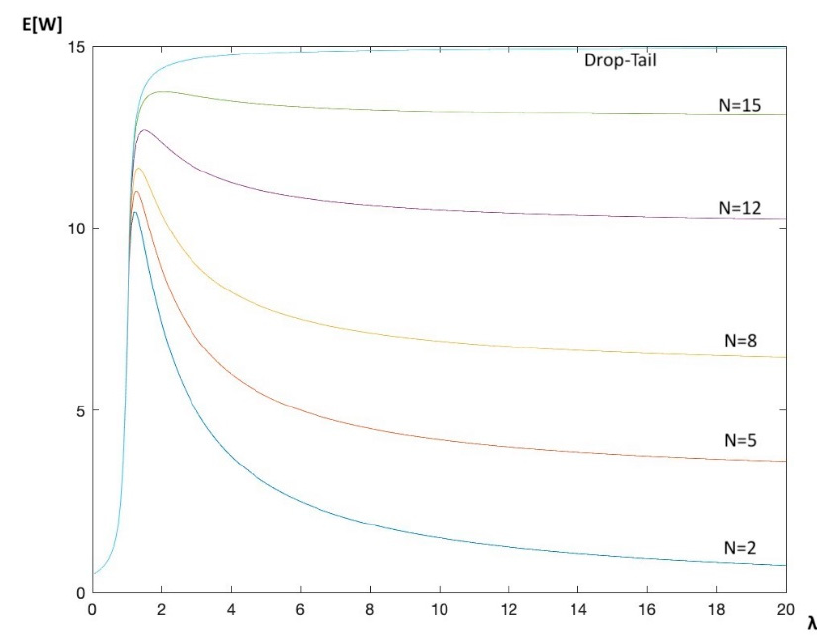
Figure 1. Mean waiting time for variable Poisson input rate for different values of 𝑁 .